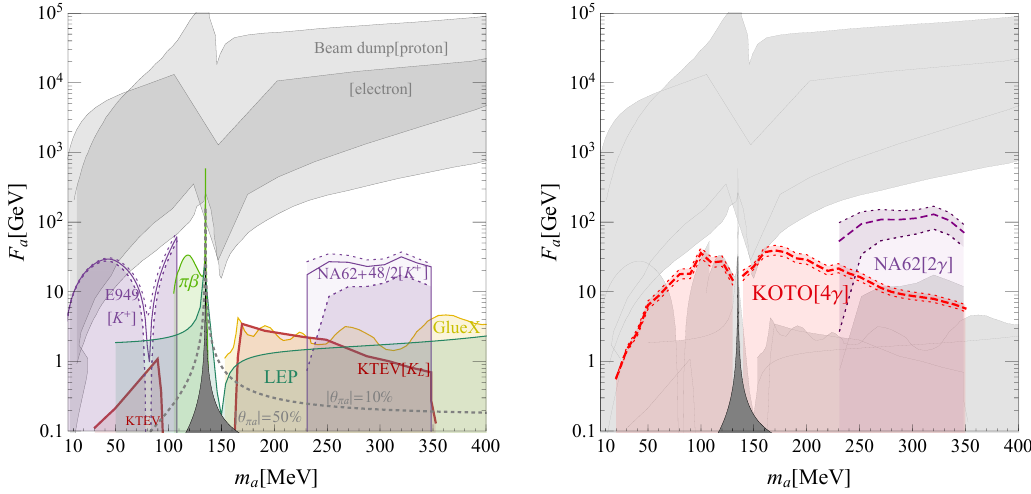
Figure 11 . Left panel: present bounds on the parameter space of the G ~ G coupled-ALP benchmark, as a function of the ALP mass, m a , and of its decay constant, F a . Right panel: present and future bounds on the parameter space. In gray, we present the present bound (as shown in the left panel); in red and purple we present the future bounds at KOTO (4 (cid:13) proposed search), and at NA62 ( (cid:25) + +2 (cid:13) signature), respectively. The bands for the Kaon experiments (E949, NA62, KOTO) show the uncertainties from the quark mass values. See the main text for the